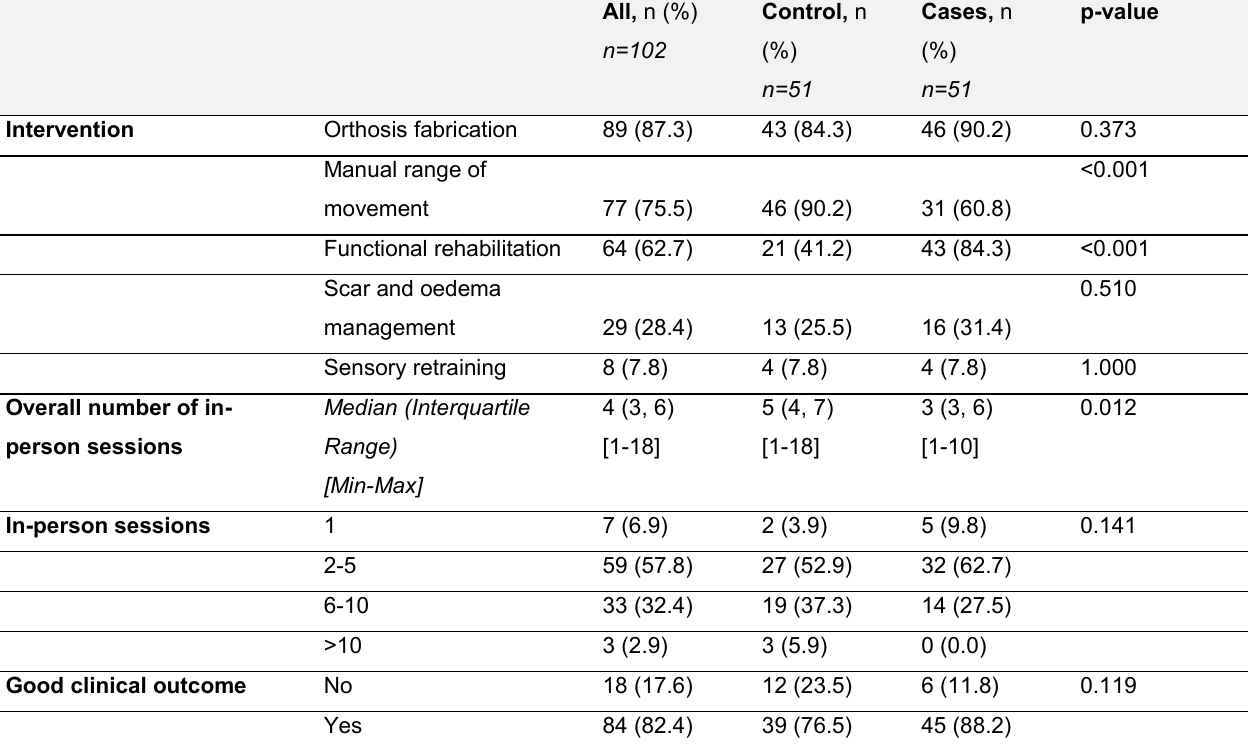
Clinical Intervention Provided and Outcomes for Case and Control Group